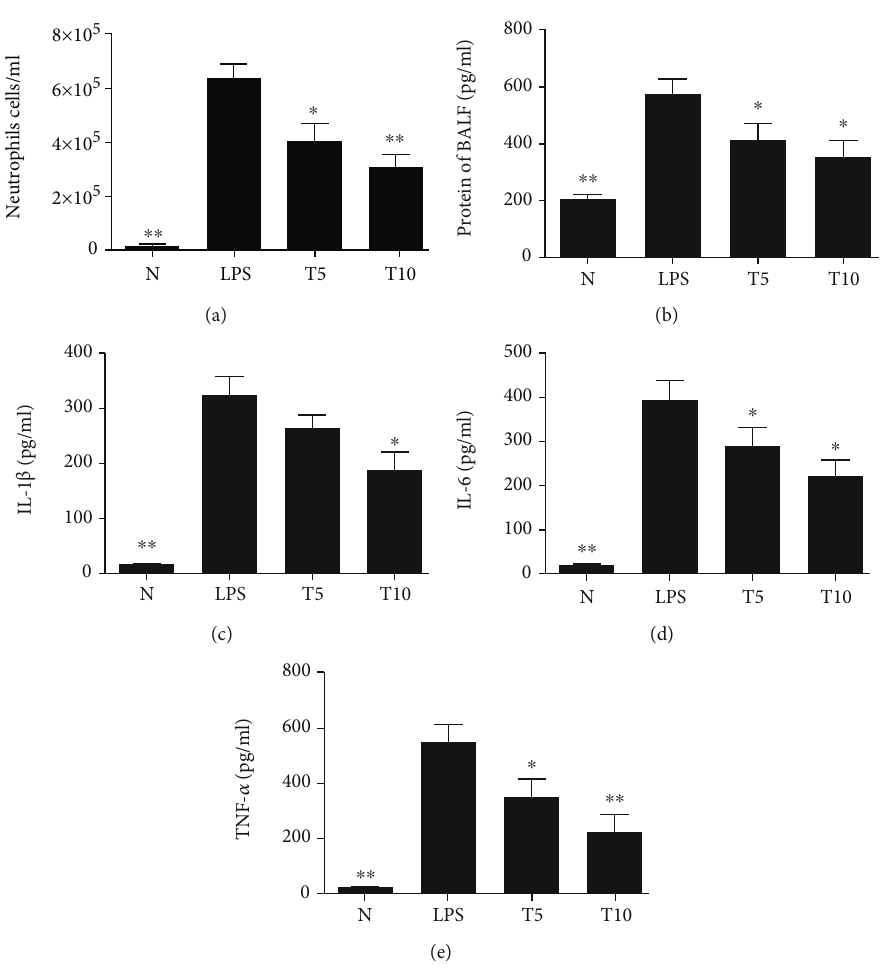
Figure 1: Tomatidine alleviated LPS-induced lung injury. Tomatidine a ff ected (a) neutrophil numbers and (b) protein concentrations in the BALF. Tomatidine reduced (c) IL-1 β , (d) IL-6, and (e) TNF- α concentrations in the BALF. Data are presented as the mean ± SEM . ∗ p < 0 : 05 and ∗∗ p < 0 : 01 vs. LPS group. N group: normal control mice; LPS group: LPS treatment only; T5 group: 5mg/kg tomatidine plus LPS; T10 group: 10 mg/kg tomatidine plus LPS.